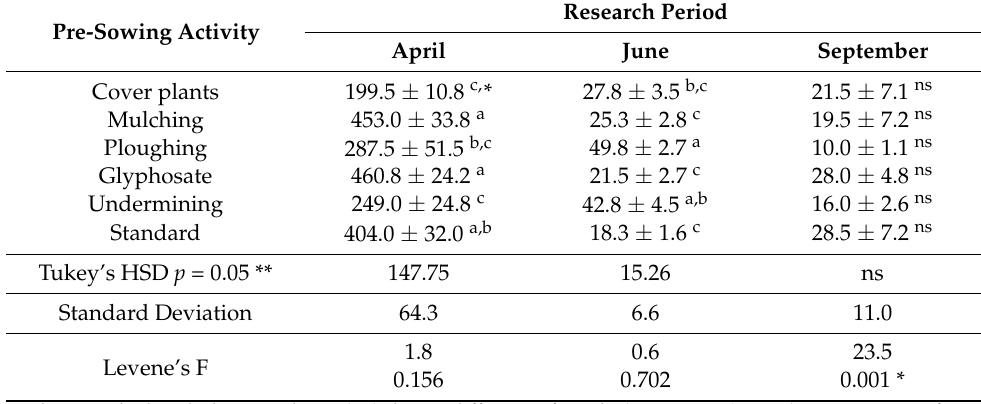
Table 3. Total catches of soil fauna ( ± standard error: SE) on all variants throughout the research period. Pre-Sowing